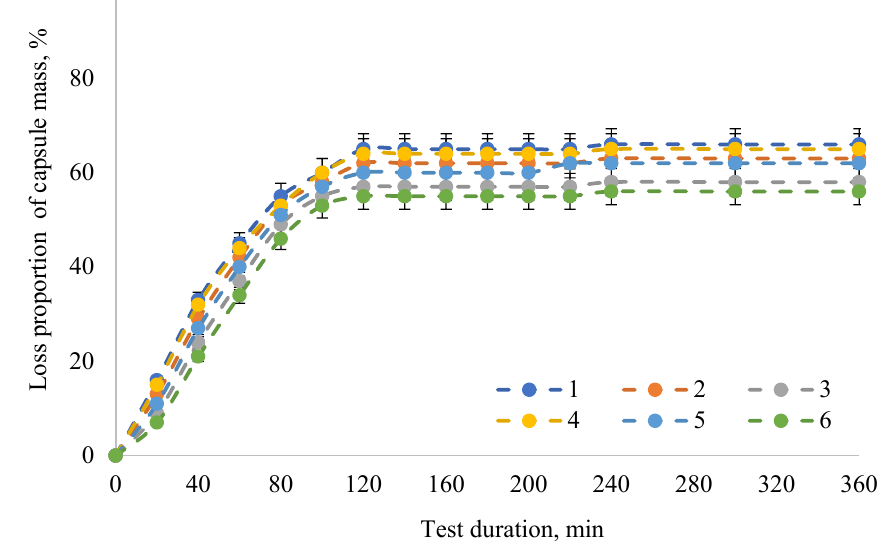
Figure 1. Dynamics of the in vitro degradation of the encapsulated form of the PAL enzyme preparation in distilled water: 1—samples of capsules made according to the formulation No. 1; 2—samples of capsules made according to the formulation No. 2; 3—samples of capsules made according to